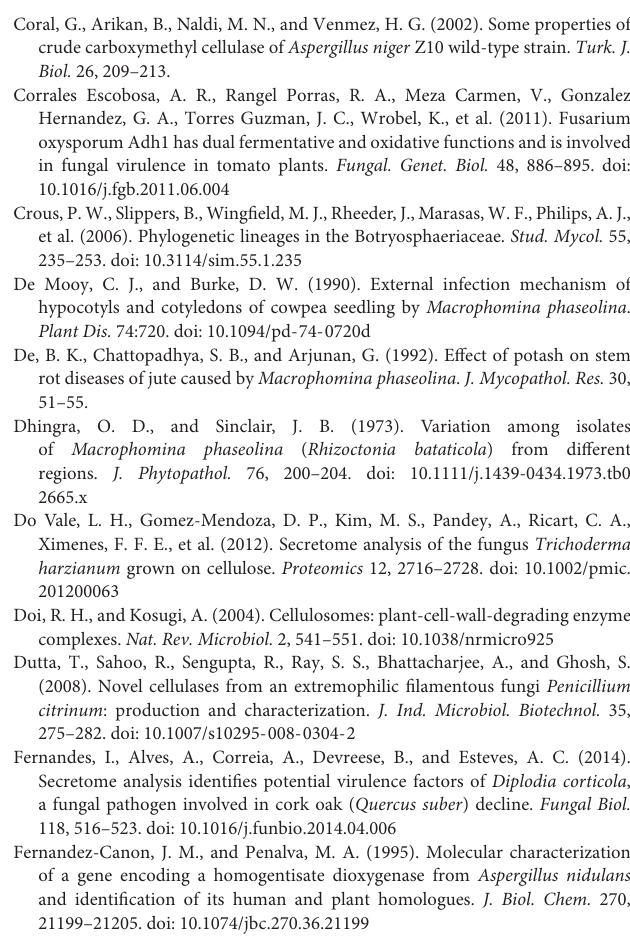
Supplementary Figure 1 | Secretome profile of M. phaseolina grown in solid state culture using wheat bran as substrate. Secretome of M. phaseolina was collected after 5, 8, 11 and 14 days post inoculation in solid state culture, and 50 µ g extracted protein was run in SDS-PAGE. Molecular weight markers were also run in the same